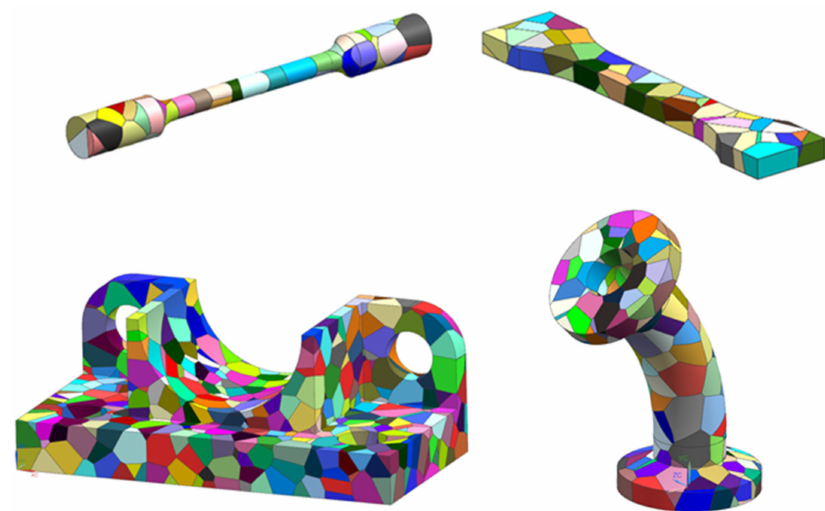
Figure 5. Examples of arbitrary solid shapes with Voronoi